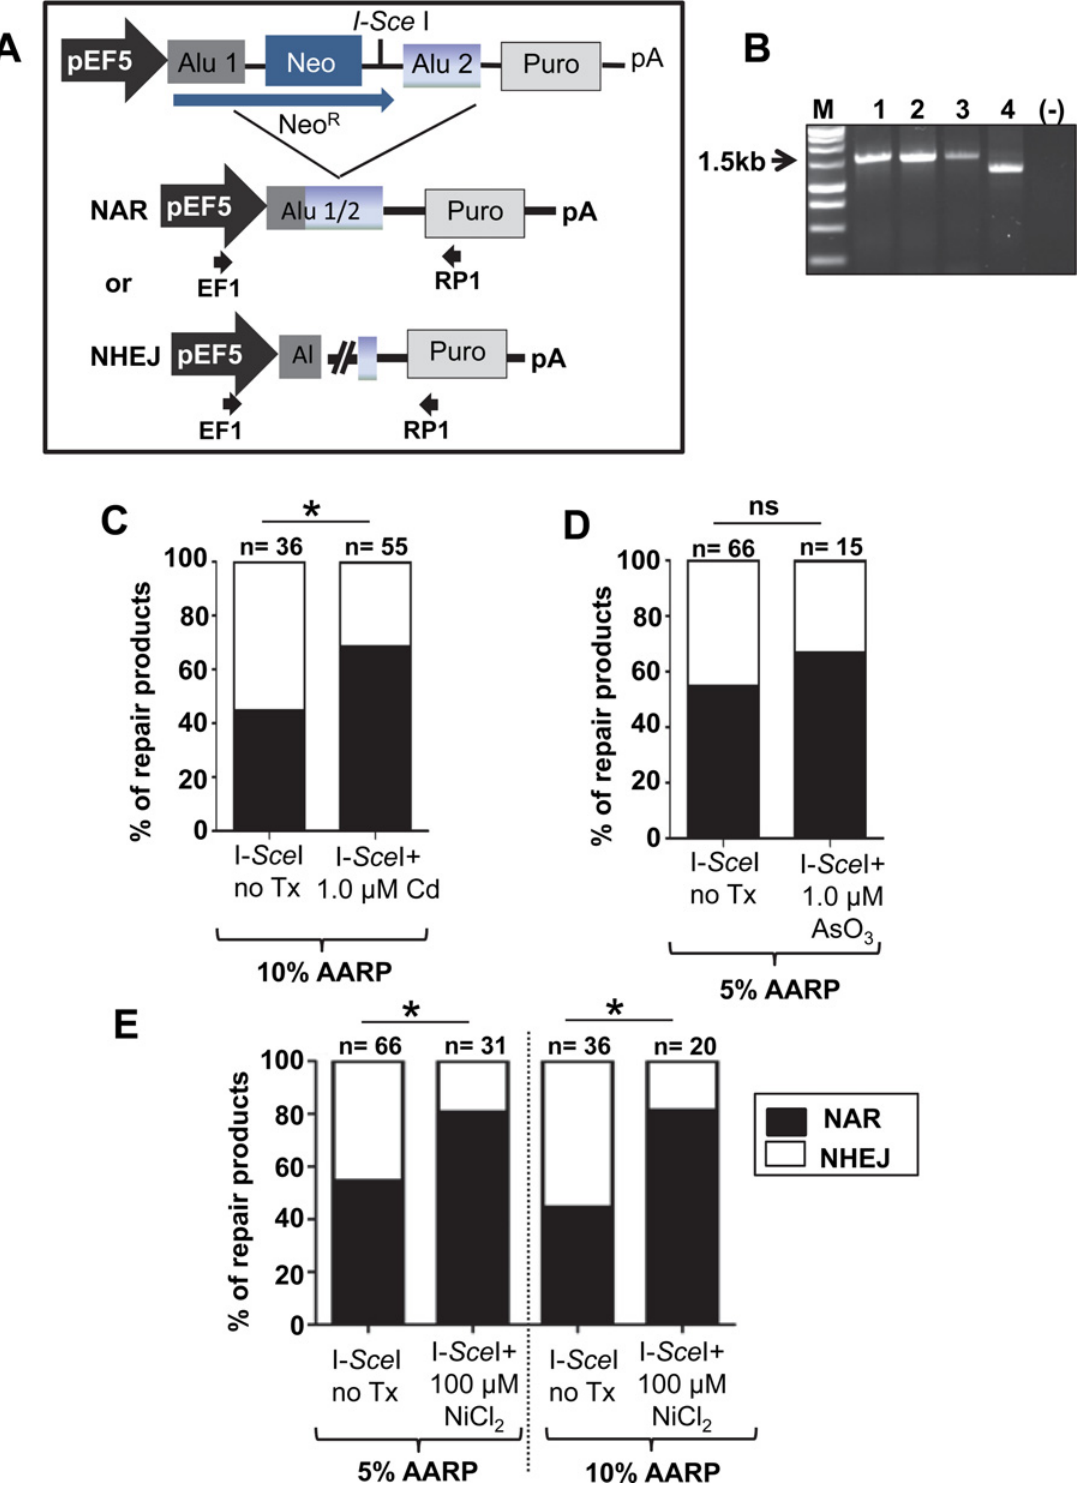
Fig 3. Heavy metal exposure favors NAR repair over NHEJ repair of induced DSBs. Cells containing two different AARP constructs with sequence diverged Alus (5 and 10% sequence variation between Alu1 and Alu2) were used. The cells were transfected with an I- Sce I expressing construct and allowed to repair in the presence or absence of heavy metals. Individual puro R colonies were selected for DNA extraction. PCR products of the repaired event from